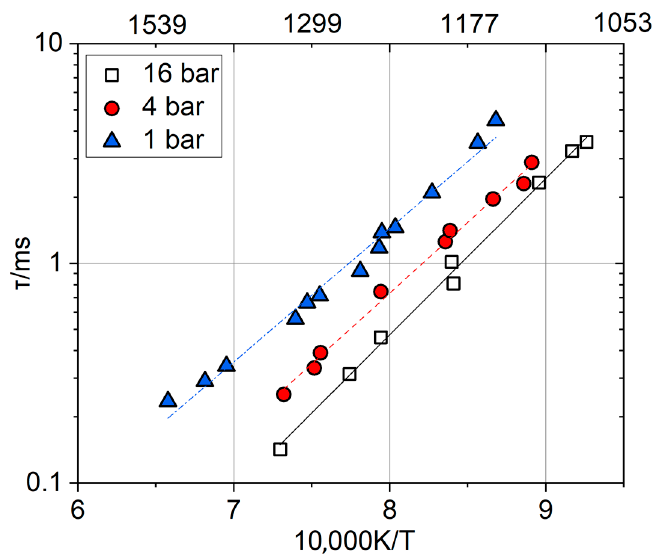
Figure 7. Change in the ignition delay time depending on pressure (experiment Φ =0.5, mixture of 40% H2 and 60% natural gas by volume) [14].